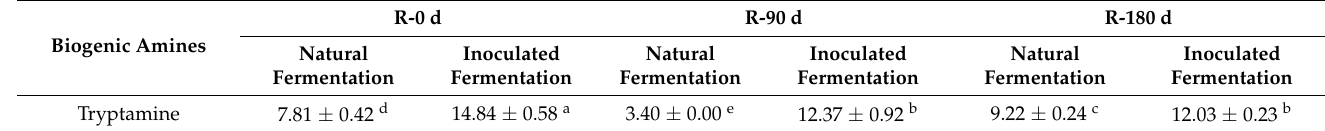
Table 7. Biogenic amine content in natural and inoculated fermented sufu at 0 d, 90 d and 180 d of